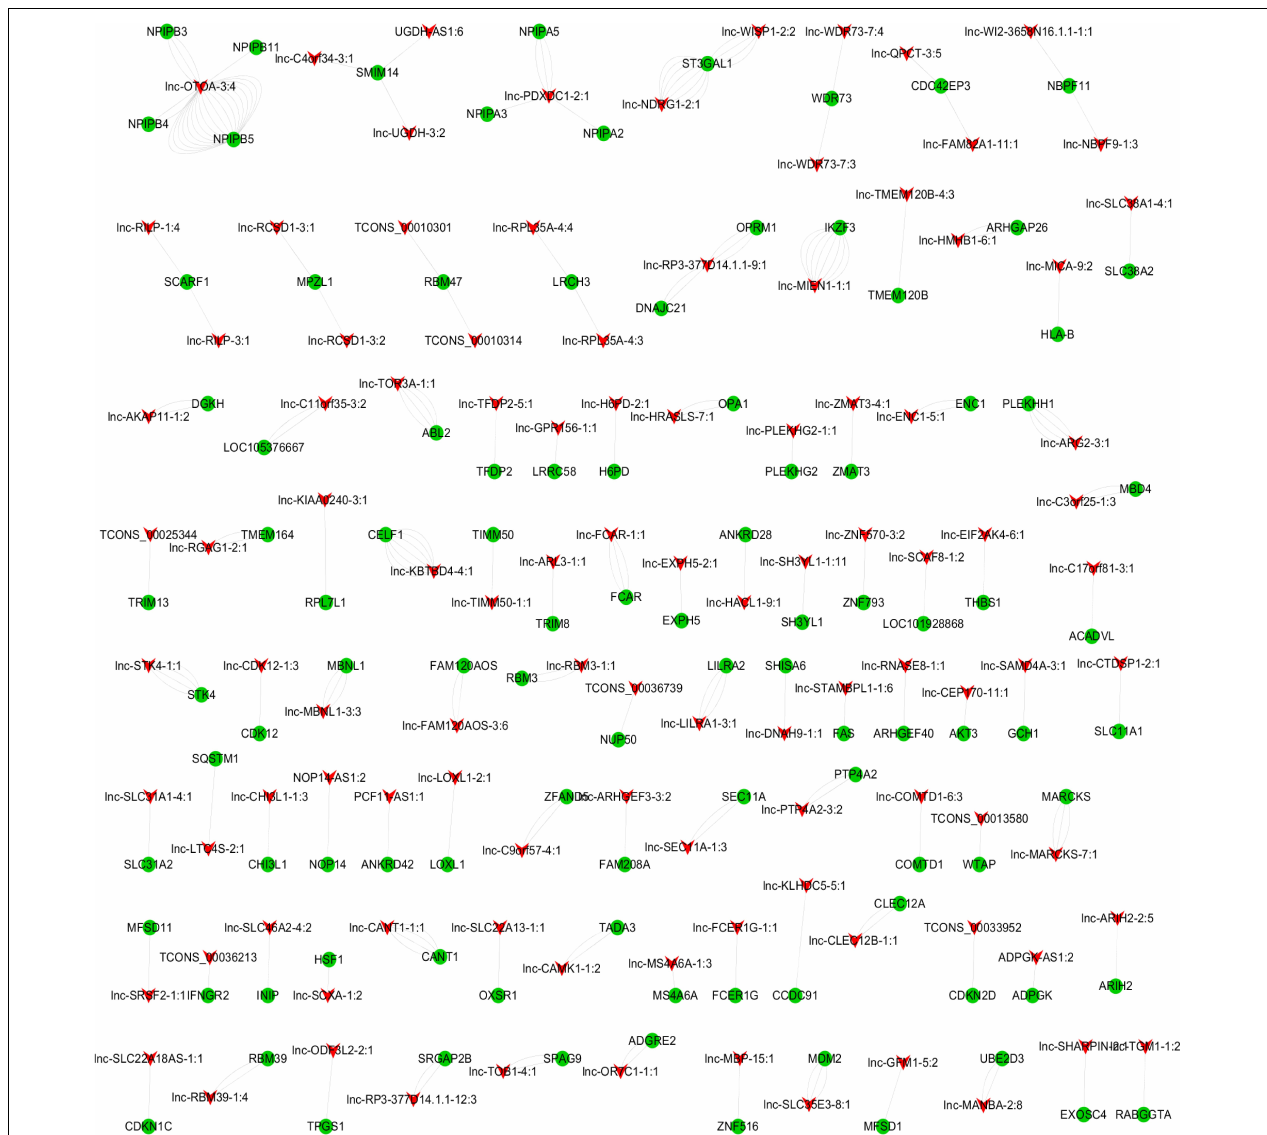
FIGURE 5 | lncRNA-mRNA interaction network in a trans manner. Kyoto Encyclopedia of Genes and Genomes (KEGG) analysis indicated that the significantly ( p < 0.05) enriched pathways in the lncRNA-targeted genes mainly included adipocytokine signaling pathway, ErbB signaling pathway, FoxO signaling pathway, etc. ( Figure 6